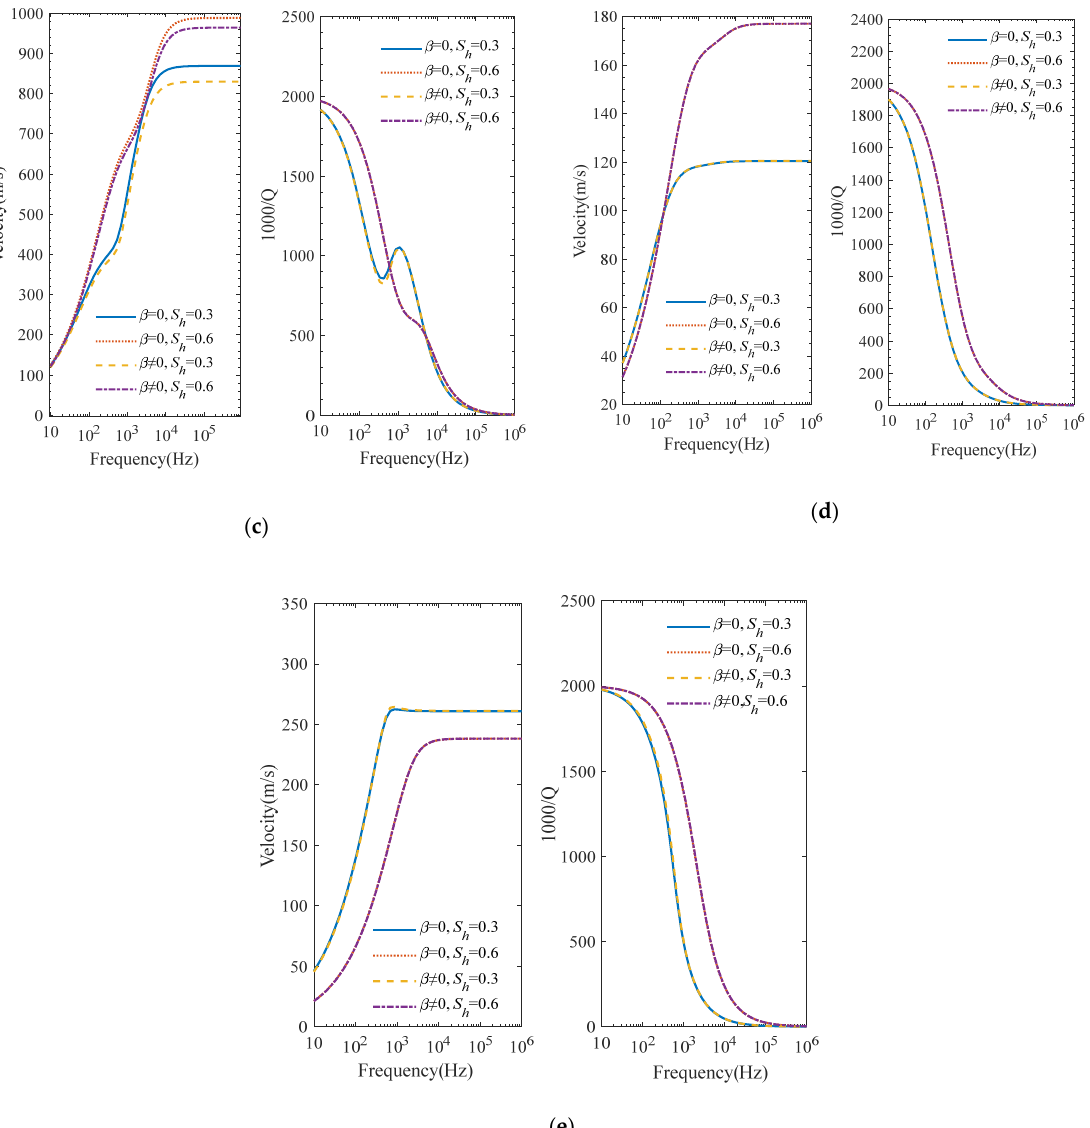
Figure 6. Effects of clay on the velocities and attenuations of five waves. Gas hydrate saturation (S h ) of 0.3 and 0.6 are considered. Different saturations and clay contents are marked in the figures: ( a ) P1; ( b ) S1; ( c ) P2; ( d ) S2; ( e )